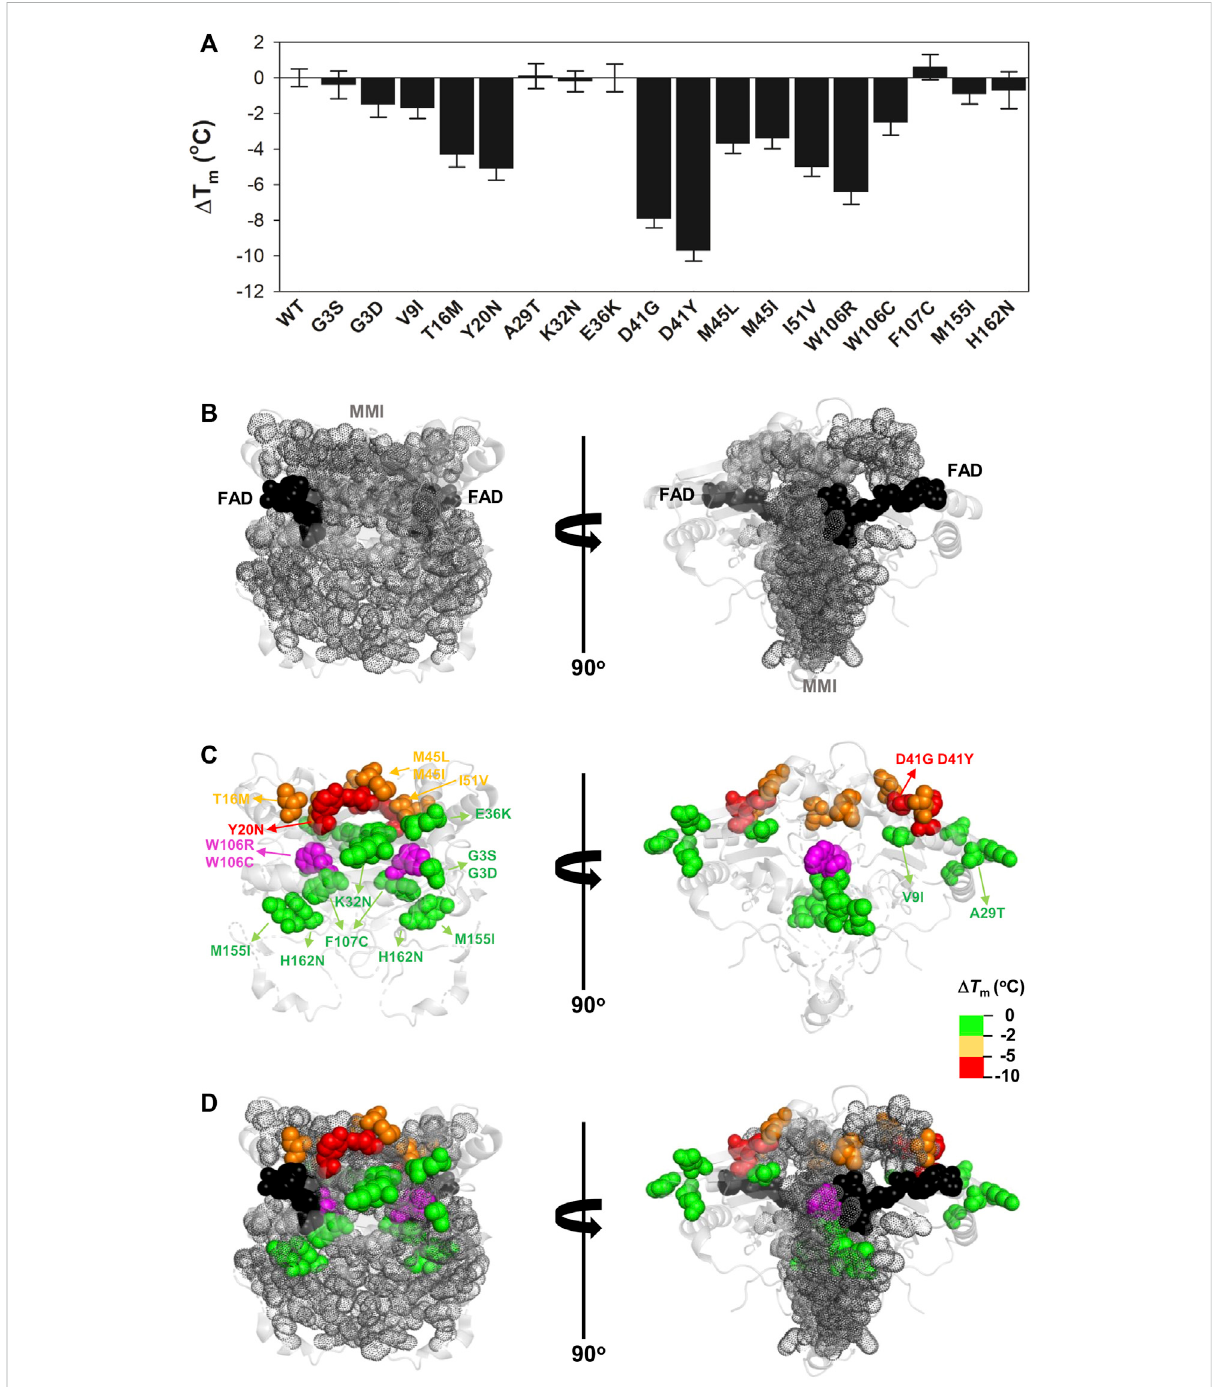
FIGURE 4 Variant effects on thermal stability related to their location near the MMI or the bound FAD. (A) Experimental Δ T m values for individual variants; (B – D) Structural location of the FAD (black spheres) and the MMI (grey dots) (B) and mutated residues (colour scale according to their destabilizing effect) (C) . (D) showsanoverlayof (B,C) .Notethattwoviewsrotated90 ° areshown.ThestructuralmodelusedfordisplaywasPDBcode2F1O(Asher et al., 2006). The residue W106 is highlighted in magenta due to the widely different effects of the W106R/W106C